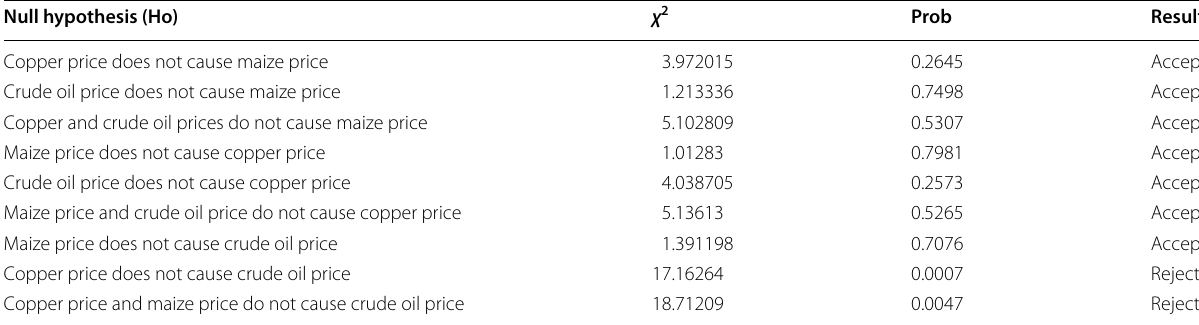
Table 13 Granger causality (1982 to 2021 data) Null hypothesis